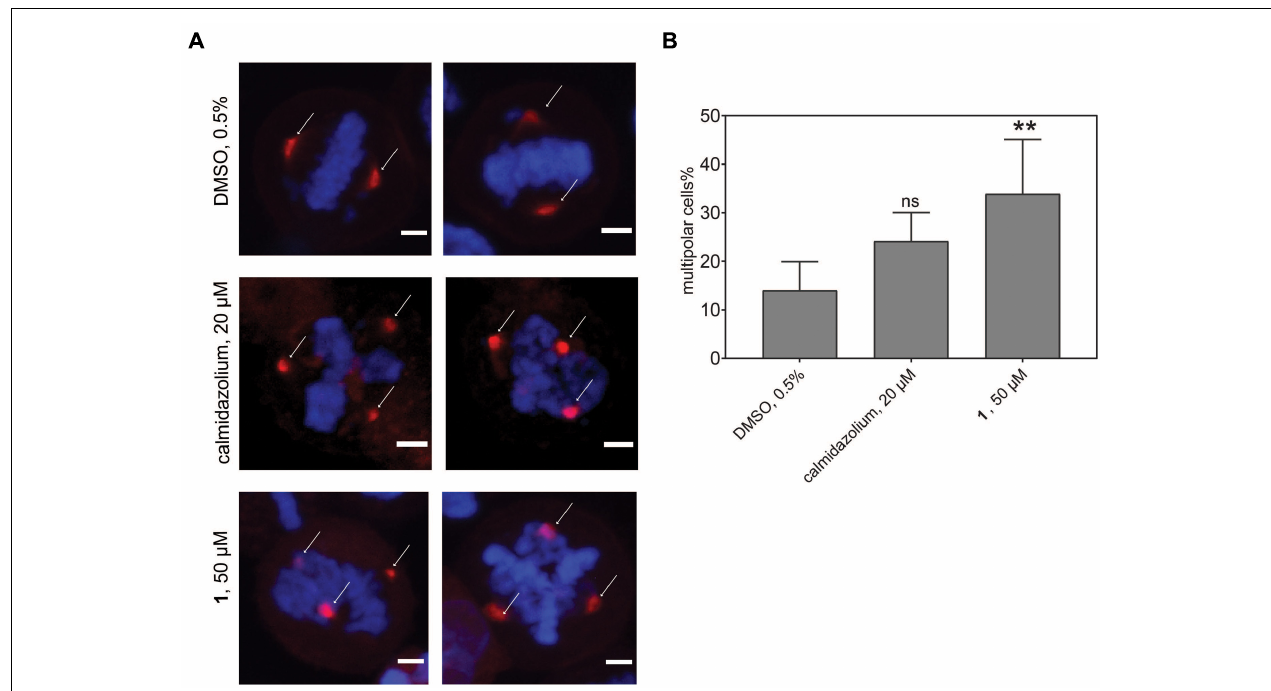
FIGURE 7 | Phenotypic effects of CaM inhibitors on centrosome numbers. (A) Representative images for bipolar normal (DMSO 0.5%, top) and multipolar centrosomes in HeLa cells after acute treatment for 2 h with calmidazolium (20 µ M, middle) 1 (50 µ M, bottom). Hela cells expressing mCherry-wtCaM (red) cells were synchronized with nocodazole to the G2/M phase for 16 h. Then cells were treated with compounds and simultaneously with the protease inhibitor MG132 (10 µ M). Arrows indicate predominant localization of mCherry-wtCaM on the centrosomes during mitosis. DNA was stained with DAPI (blue). Scale bar, 5 µ m. (B) The multipolar phenotype was quantified for each treatment from images containing 35 to 70 cells per condition. Data represent mean values ± SD, n = 3. Statistical significance was evaluated with Fisher’s exact test. The statistical significance levels are annotated as ** p < 0.01, or ns, not